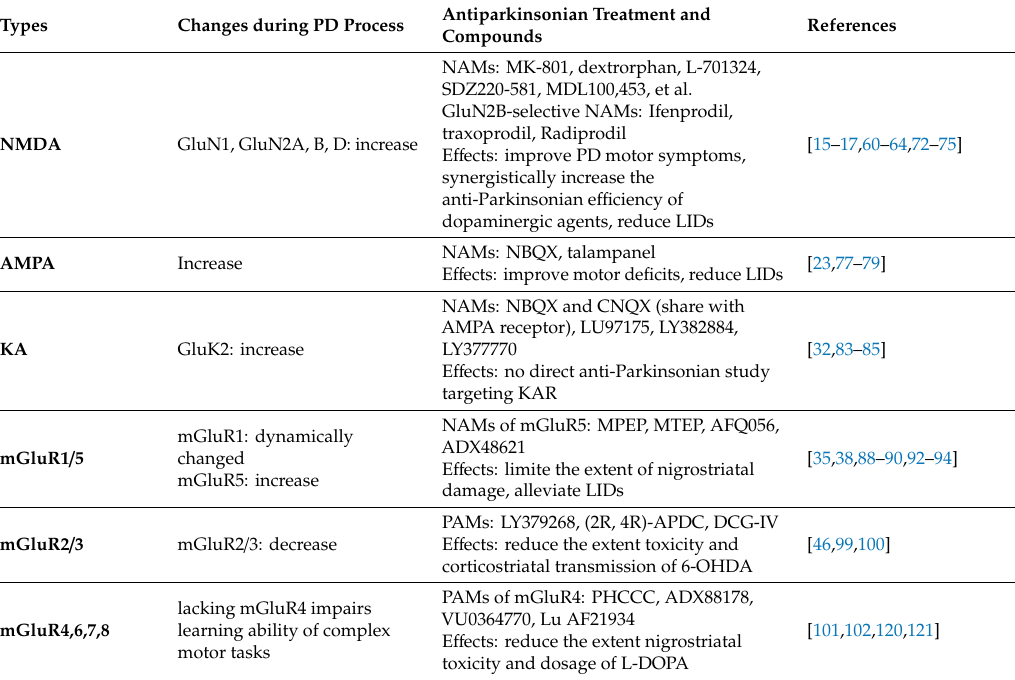
Table 1. Alterations of glutamate receptors during PD and anti-Parkinsonian